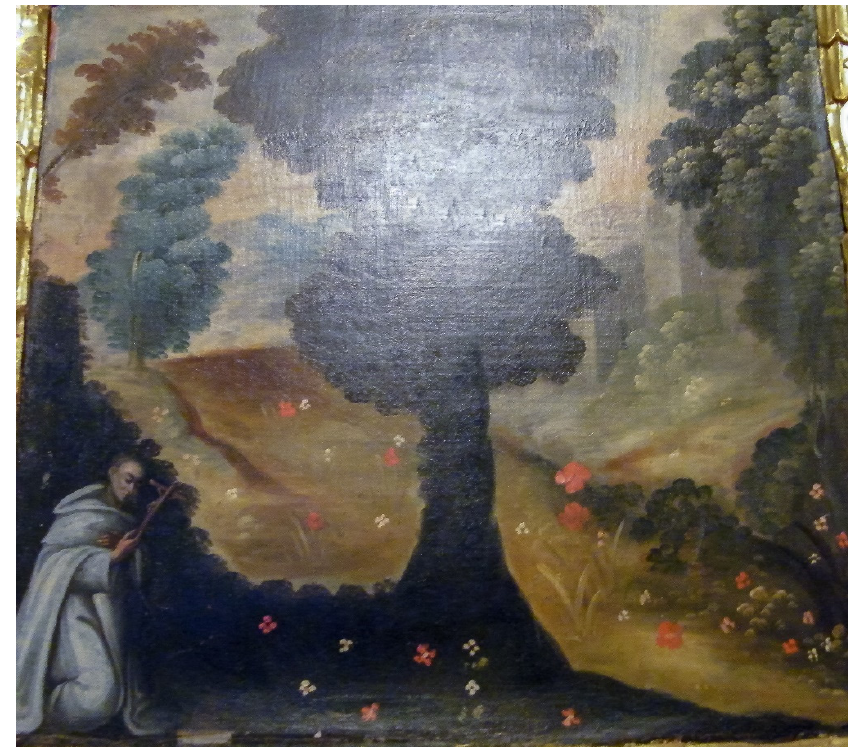
Figure 12. Unidentified artist, Contemplative Mercedarian Father , 18th century, oil on canvas. Convento de la Merced, Cuzco. Credit line: Sebastian Ferrero.